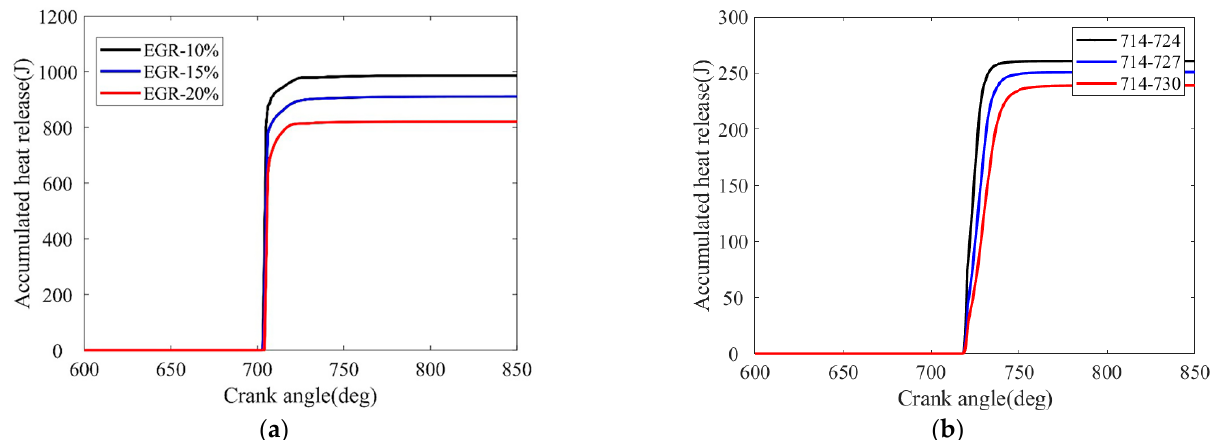
Figure 13. Accumulated heat release for different EGR rates and injection durations: ( a ) different EGR rates; ( b ) different injection durations.